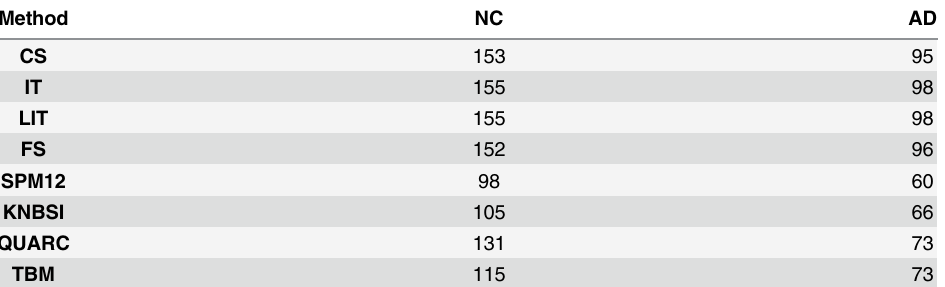
Table 3. Number of ADNI-1 subjects used for the power analyses for the different methods. These subjects were available from the downloaded results and/or passed quality controlfor each of their time-points (m0, m6, m12,